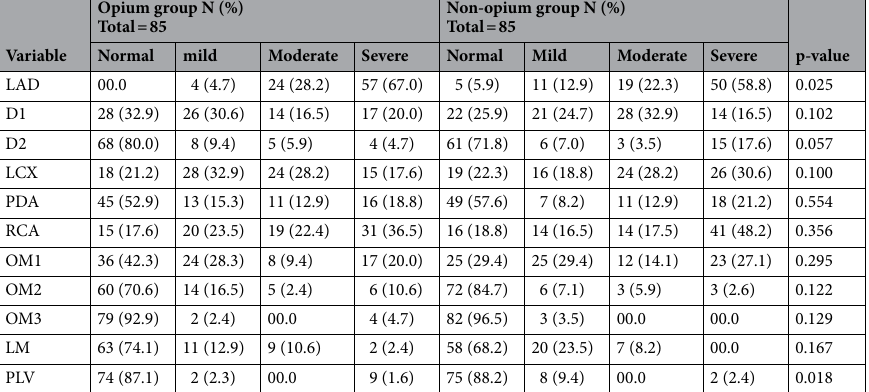
Table 1. The prevalence and severity of coronary lesions in the non-opium and opium groups. LAD left anterior descending artery, D1 first diagonal artery, D2 second diagonal artery, LCX left circumflex artery, PDA patent ductus arteriosus, RCA right coronary artery, OM1 first obtuse marginal artery, OM2 second obtuse marginal artery, OM3 third obtuse marginal artery, LM left main artery, PLV posterior left ventricular artery.